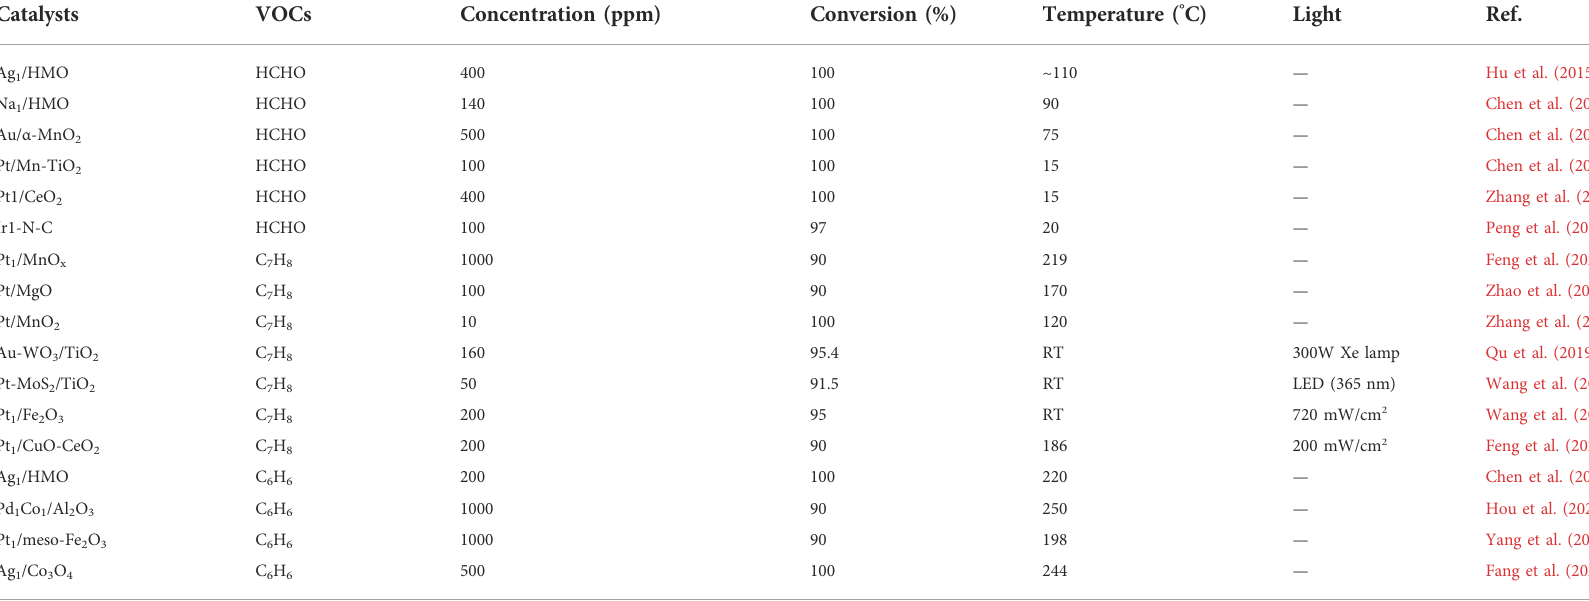
TABLE 2 The catalytic performance comparison of SACs on VOCs oxidation.